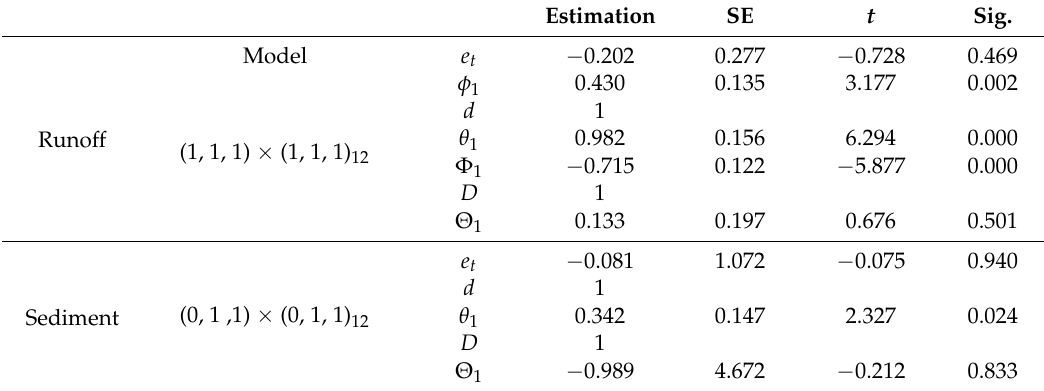
Table 5. Parameters of ARIMA